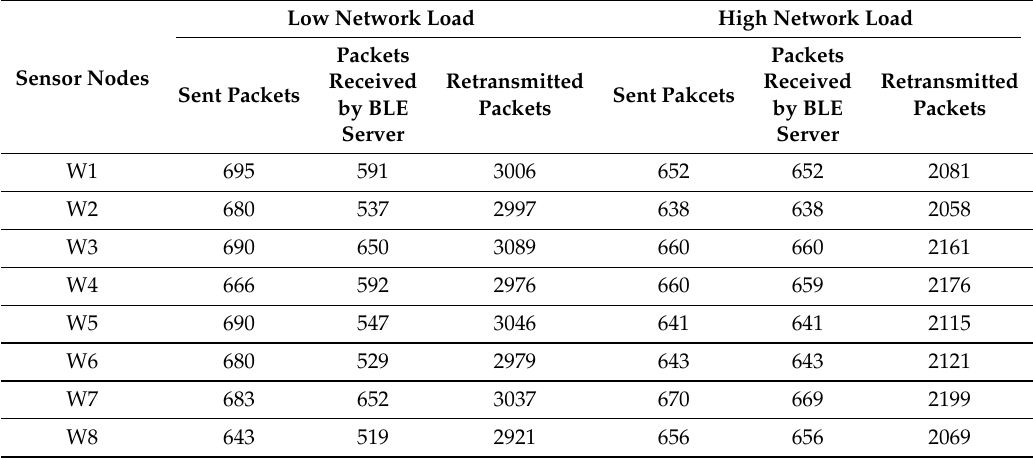
Table 17. Number of packets sent by each sensor node and received by BLE server, for each Waspmote device configuration in Collaborative Mesh and CSR devices retransmit each packet